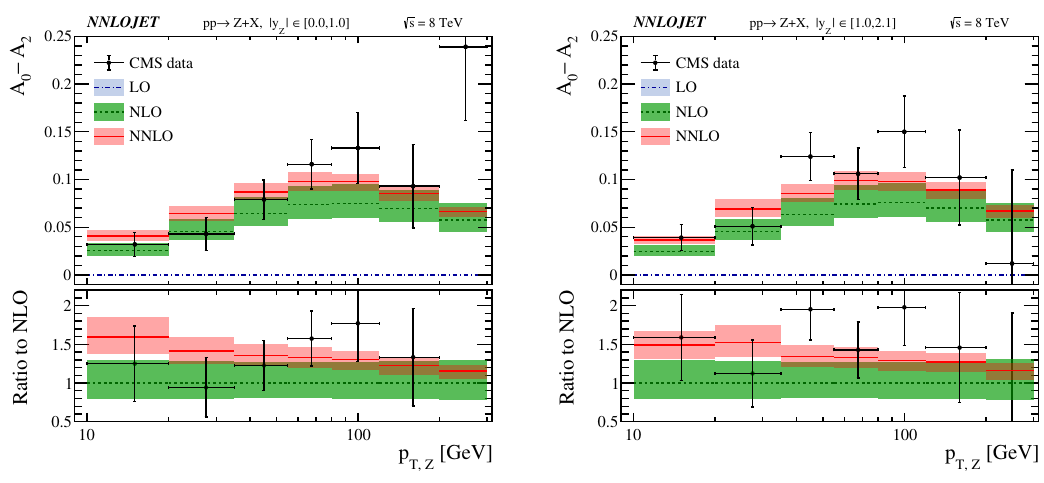
Figure 11 . The p T ; Z distribution for the di(cid:11)erence of angular coe(cid:14)cients ( A 0 (cid:0) A 2 ) in pp collisions p at s = 8 TeV, with the kinematic cuts of j y Z j 2 [0 : 0 ; 1 : 0] (left) and j y Z j 2 [1 : 0 ; 2 : 1] (right). The CMS data (black points) are compared to the LO (blue (cid:12)ll), NLO (green (cid:12)ll), and NNLO (red (cid:12)ll) theoretical predictions. In the lower panel, each distribution is shown normalised with respect to the central NLO